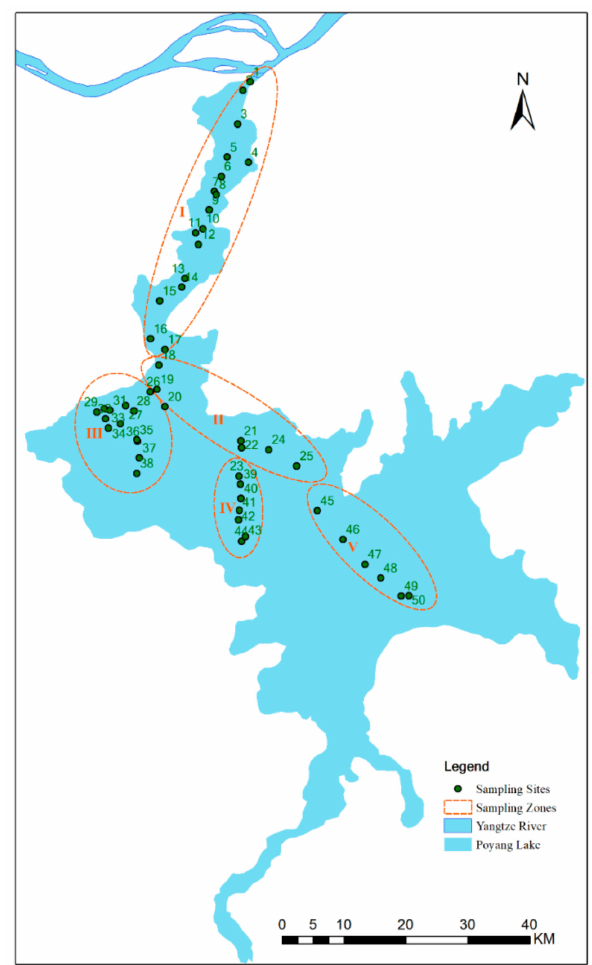
Figure 2. Spatial distribution of 50 samples in Poyang Lake during 15–23 July